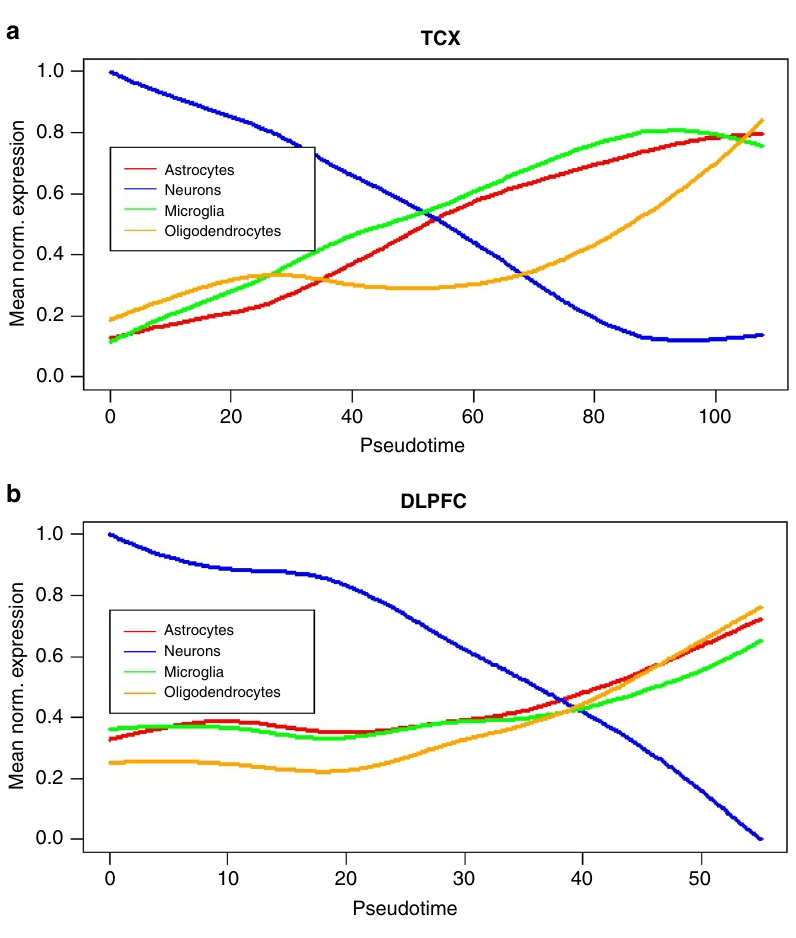
Fig. 4 Cell-type gene expression signatures as a function of disease pseudotime. a Mean expression of cell markers for astrocytes, neurons, microglia, and oligodendrocytes as a function of pseudotime for TCX brain region, b mean expression of cell markers for astrocytes, neurons, microglia, oligodendrocytes as a function of pseudotime for DLPFC ( b ) brain region.